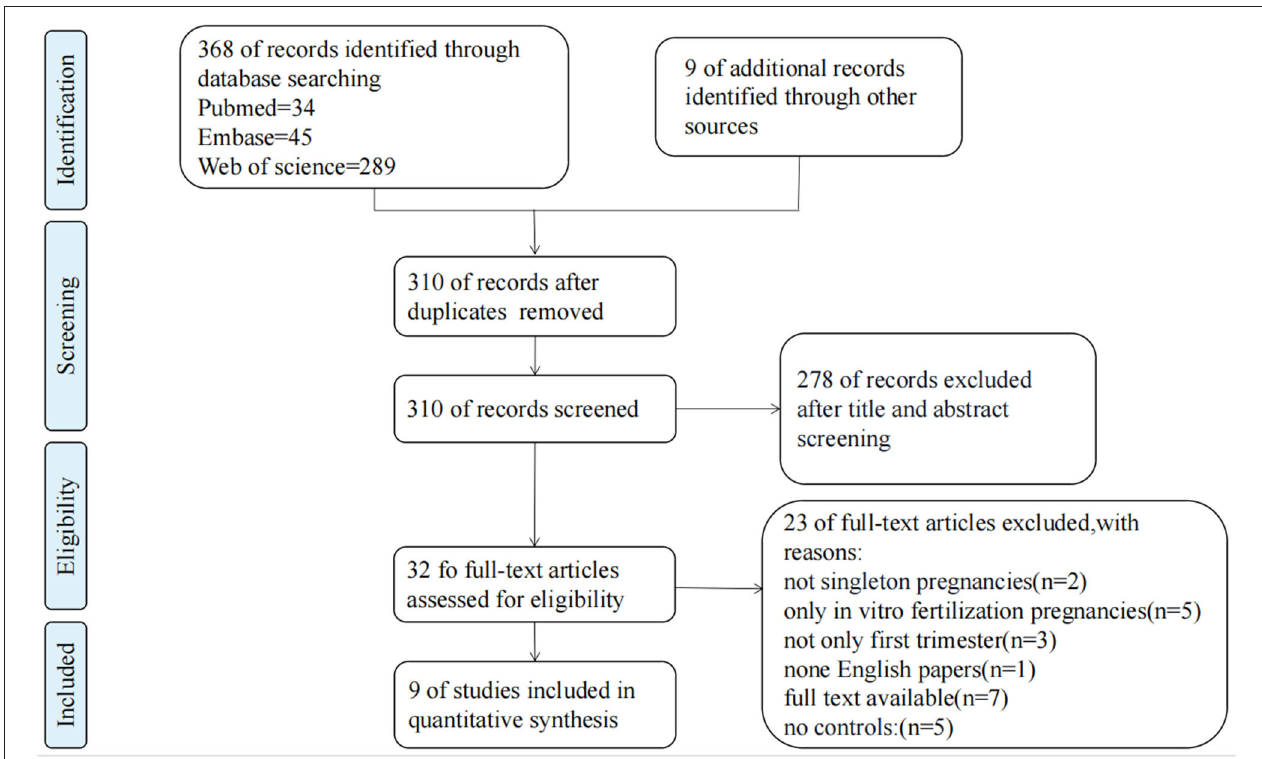
FIGURE 1 | The flow chart of study